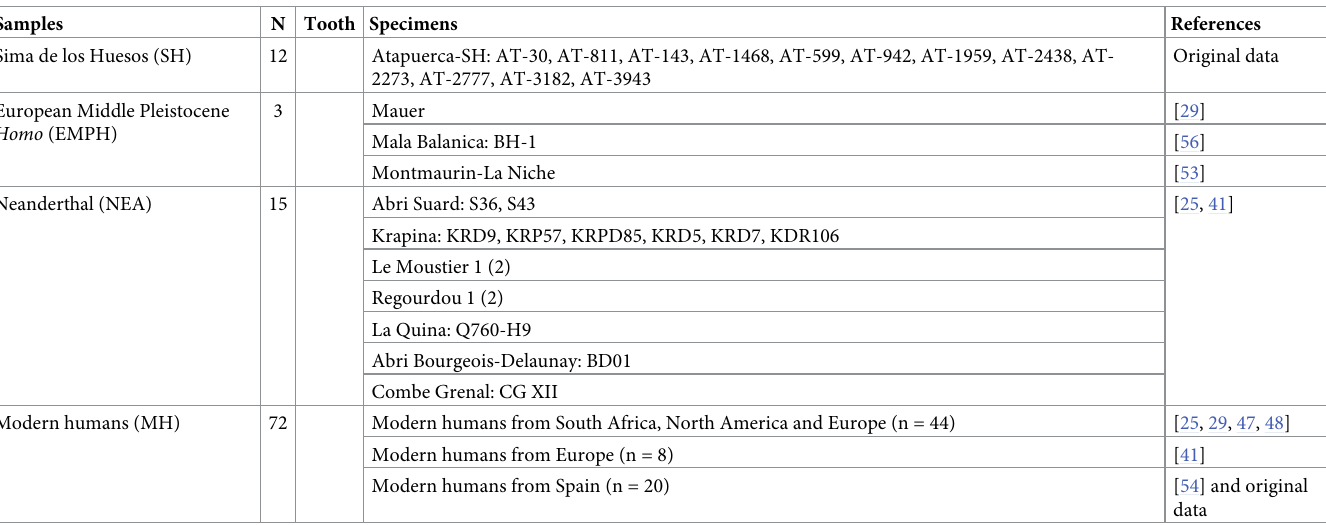
The virtual molar sectioning was performed following the protocol described in Olejniczak and colleagues [25], instead of that developed by Smith et al., [30], and based on a 2D plane perpendicular to the developmental axis of the crown. Comparisons between the methods did not reveal significant differences in average or relative enamel thickness [30]. That is, we imported the μ CT image stack into Amira (6.3.0, FEI Inc.) and rotated into anatomical posi- tion. Then, the tip of three dentine horns (protocone, paracone and metacone in the maxillary molars and protoconid, metaconid and hypoconid in the mandibular molars) were identified and the image stack was adjusted to intersect these three points of interest. Finally, a new plane perpendicular to the plane containing the three dentine horns was rotated to pass through the mesial dentine horns (protocone and paracone in the maxillary molars and protoconid and metaconid in the mandibular molars) ([25] and also see S1 Fig) 39 out of the 72 SH molars were discarded for exhibiting wear score higher than two in Molnar’s classification